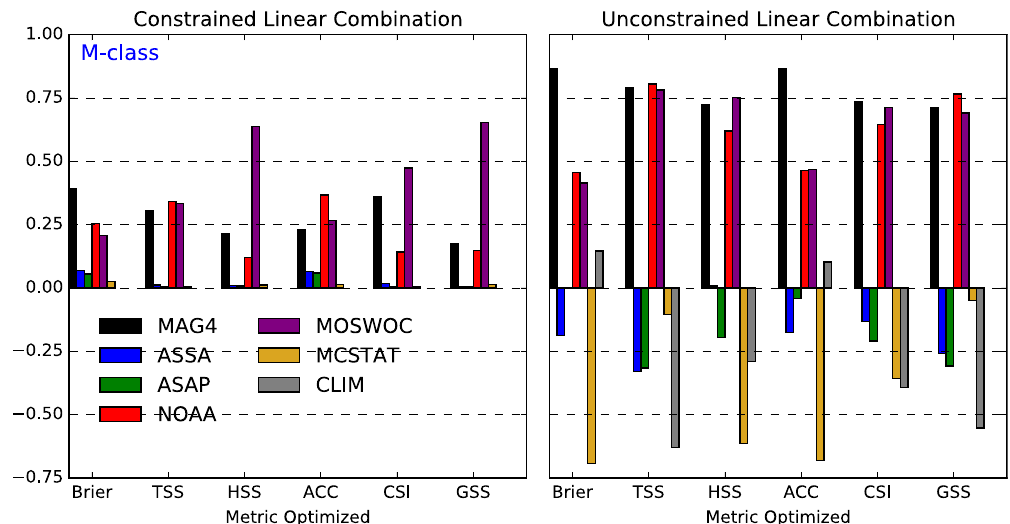
Fig. 4. Similar to Figure 3, but for the optimization of categorical metrics (Table 3, right